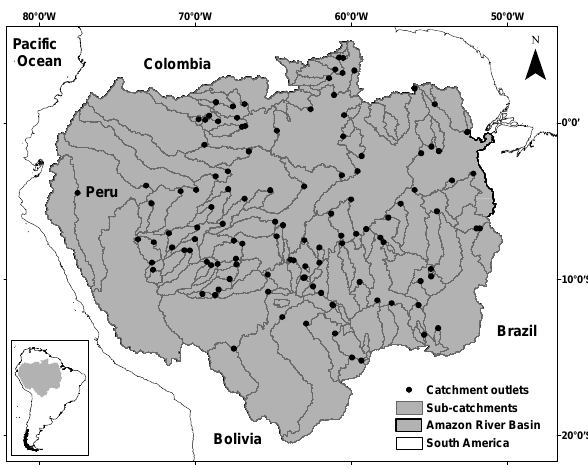
Figure 2. Location of the study area and the 146 sub-catchments in the Amazon River